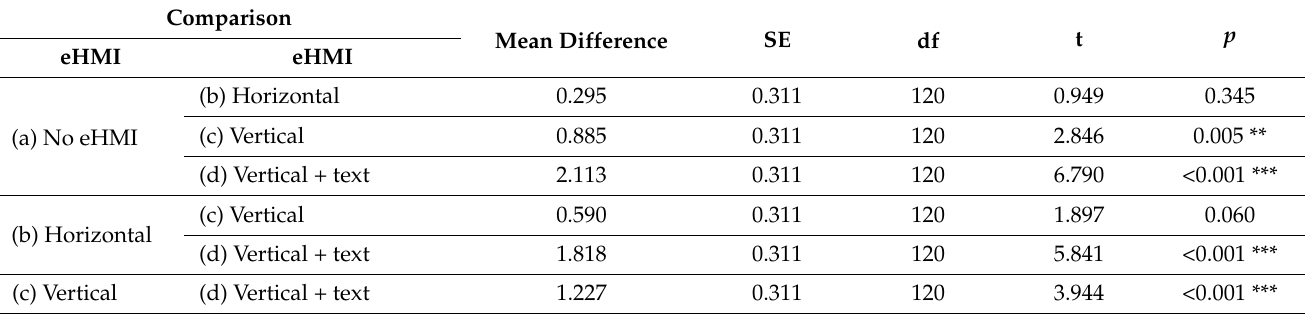
Table 5. Post hoc comparison of the time until the maximum of the willingness to stop scale was